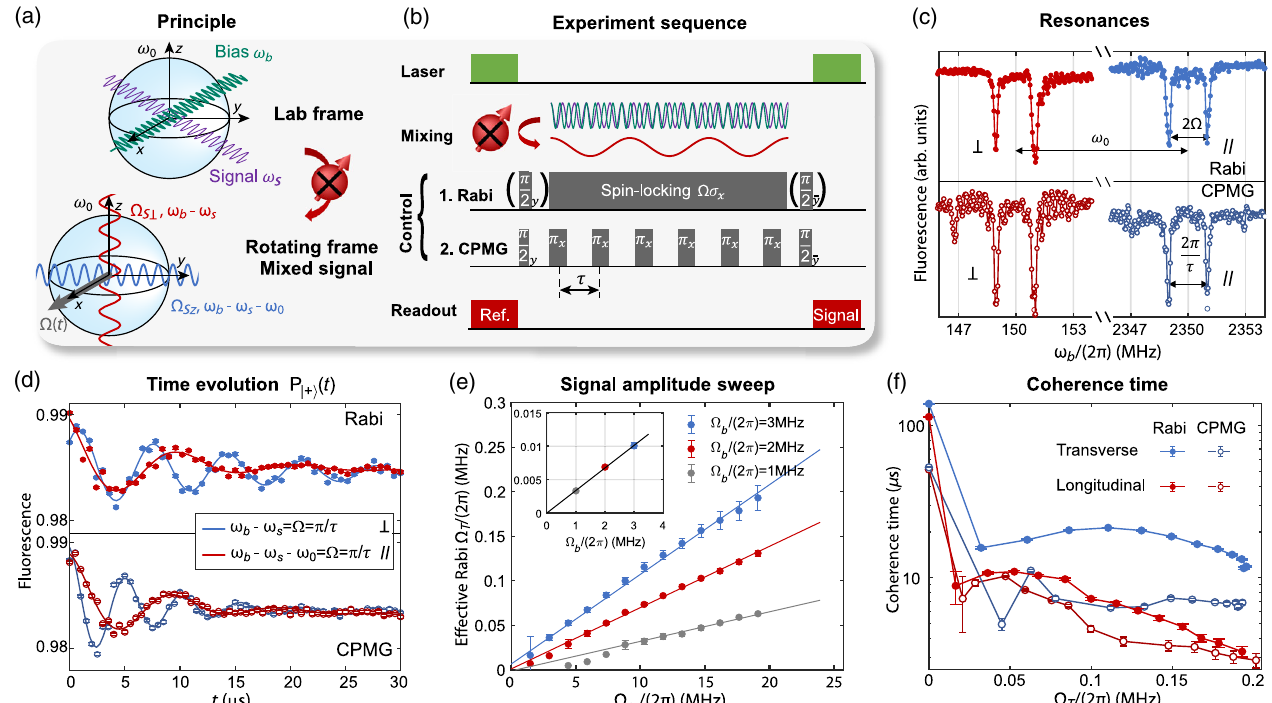
FIG. 4. Vector ac magnetometry. (a) Principle of vector ac magnetometry with quantum frequency mixing. (b) Experimental sequence. (c) ESR measurement. The initialization and readout state is jþi . The control fields are set to Ω ; π = τ ¼ ð 2 π Þ 1 MHz, and the π pulse length for CPMG is 0 . 167 μ s. A linearly polarized signal field with frequency ω s ¼ ð 2 π Þ 150 MHz, phase ϕ s ¼ 0 , and amplitude 2 π Þ 15 . 3 MHz, Ω 2 π Þ 10 . 4 MHz is applied as the target to be sensed. A bias field with tunable frequency ω Ω sx ¼ ð sz ¼ ð b is applied with amplitudes Ω b ¼ ð 2 π Þ 15 . 3 MHz for the low-frequency range to sense the transverse signal and Ω b ¼ ð 2 π Þ 3 MHz for the high- frequency range to sense the longitudinal signal. For the Rabi method, the evolution duration is set to 3 . 5 μ s ( 4 μ s) for the low- (high-) frequency range, while for the CPMG method, the pulse number is set to 6 (8) for the low- (high-) frequency range. (d) Time evolution measurement under resonance conditions. The experimental parameters are the same as in panel (c), and the data are fit to the function S ð t Þ ¼ c 0 . 5 c cos ð Ω t Þ e − t=T 2 ρρ þ ξ t , where ξ is a phenomenological drift factor. (e) Signal amplitude sweep under different bias 0 þ T amplitudes. The Rabi frequency for the longitudinal component sensing is measured as a function of signal amplitude under three different bias field amplitudes. The slopes for the signal sweep under different bias amplitudes are plotted in the inset and fit to a linear trend. Because of large error bars (not shown) for ultraslow Rabi oscillation measurements, the first two (three) data points for Ω = ð 2 π Þ ¼ 2 ð 1 Þ MHz are not included when fitting the linear curve. (f) Measured coherence time T b 2 ρρ . The time evolution induced by the effective transverse and longitudinal signals is measured in the rotating frame. The signal amplitude is swept, while the other experimental parameters are the same as the time evolution measurement in panel experiment with ω T ¼ (cid:2) π = τ yields S ð t Þ ¼ ð 1 = 2 Þ½ 1 þ